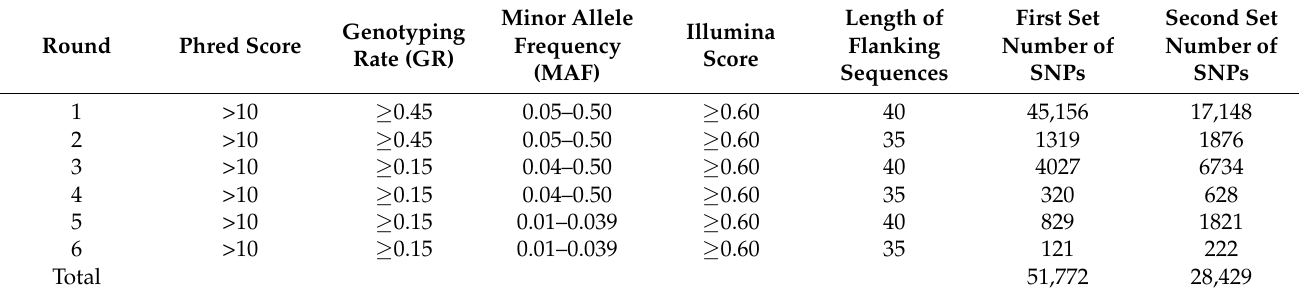
Table 2. Selection of the first and second sets of single nucleotide polymorphisms (SNPs) by location score.